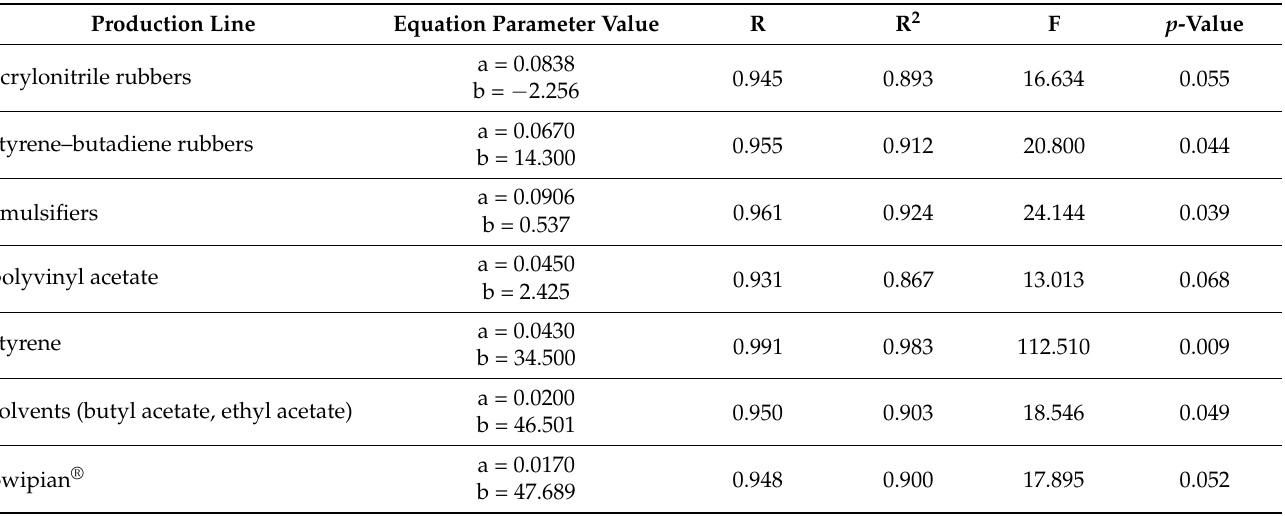
Table 11. Summary of statistical parameters of the linear regression analysis assessing the effect of COD in industrial wastewater on the nitrification inhibition.